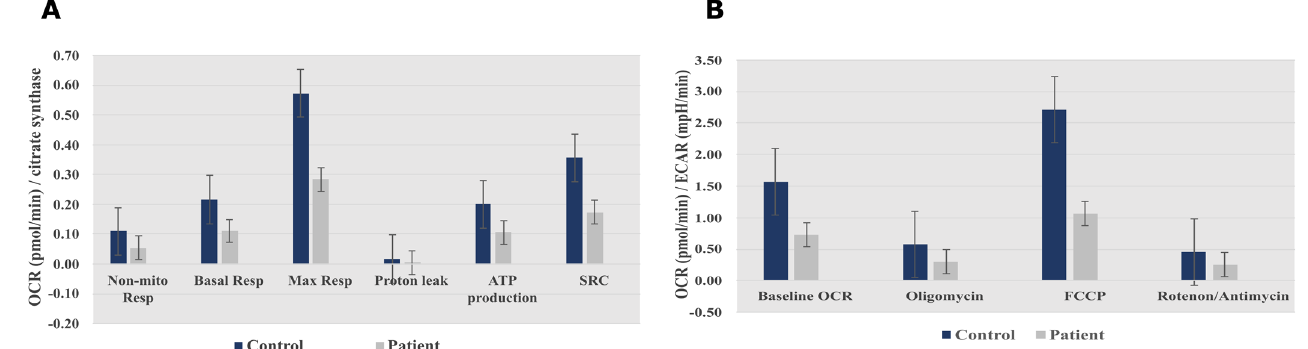
Figure 3. Seahorse XF96 respirometry analysis. ( A ) Oxygen consumption rate measured before and after the addition of